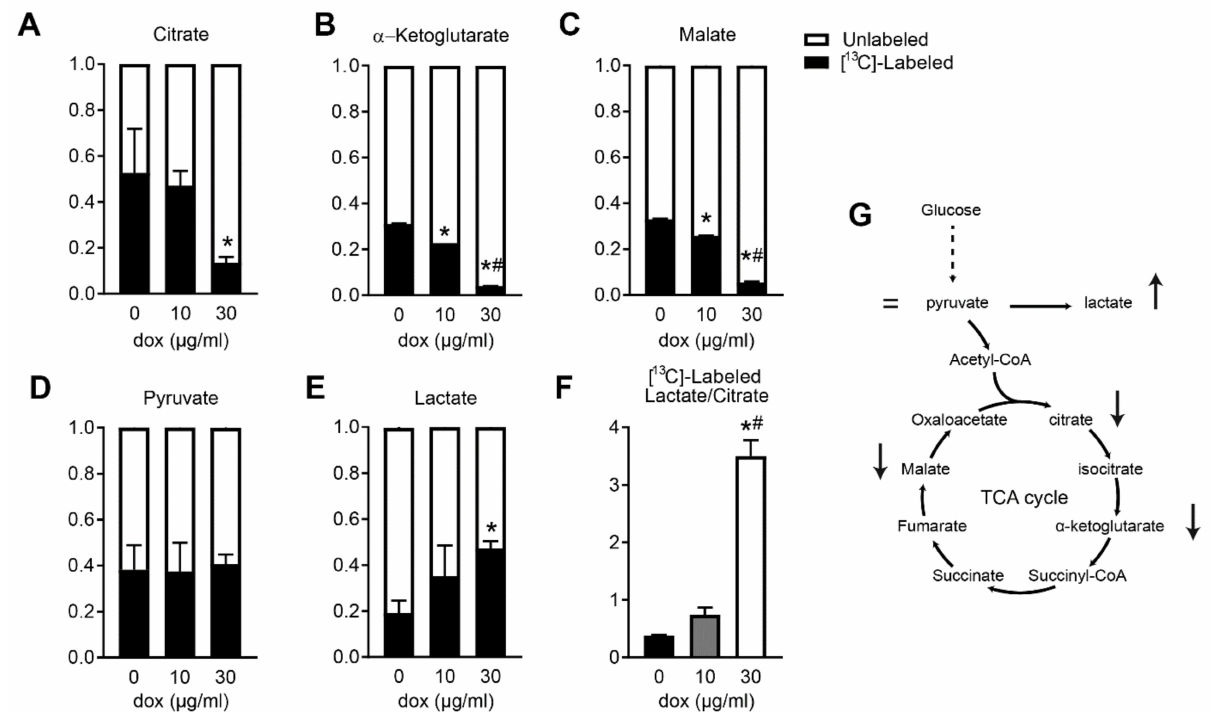
Figure 2. Reduced glucose flux into the tricarboxylic acid (TCA) cycle in H9C2 cardiomyoblasts exposed to doxycycline. ( A – C ) Doxycycline resulted in a lower percentage of incorporation of [ 13 C 6 ]-labeled glucose into tricarboxylic acid (TCA) cycle intermediates citrate, α -ketoglutarate, and malate. ( D ) Incorporation into pyruvate (both part of the glycolysis and TCA cycle) did not change. ( E ) More incorporation of [ 13 C 6 ]-labeled glucose in intracellular lactate after doxycycline. ( F ) Ratio of [ 13 C]-labeled lactate/citrate increased after doxycycline treatment, indicating a metabolic shift from TCA cycle to glycolysis. ( G ) A graphical overview of the positive or negative changes in glycolytic and TCA cycle intermediates after doxycycline exposure. Bar graphs are expressed as mean ± SEM. *: p < 0.05 vs. vehicle; #: p < 0.05 vs. 10 µ g/mL doxycycline, one-way ANOVA followed by Tukey’s post-hoc test for multiple